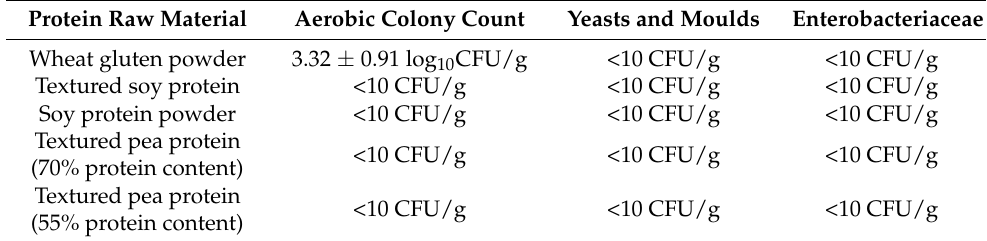
Table 2. Initial microbial load of protein raw materials.